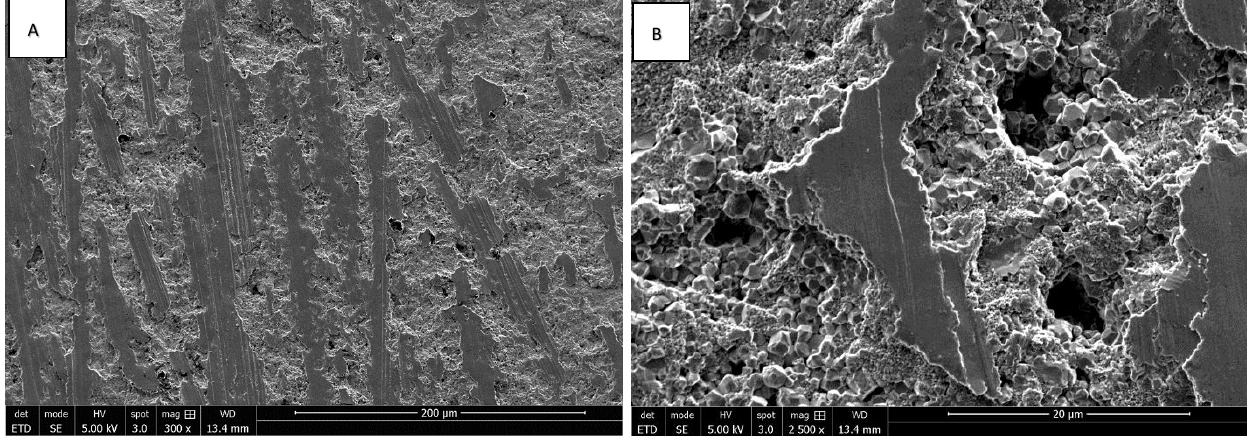
Figure 2 . SEM images of rough (( A ) magnification 300×; ( B ) magnification 2500×) and smooth surfaces (( C ) magnification 300×; ( D ) magnification 2500×) of Y-TZP discs. Figure 3 . SEM images of smooth surfaces of ZrO 2 (( A ) magnification 300×) and Y-TZP (( B ) magnification 300×) discs.